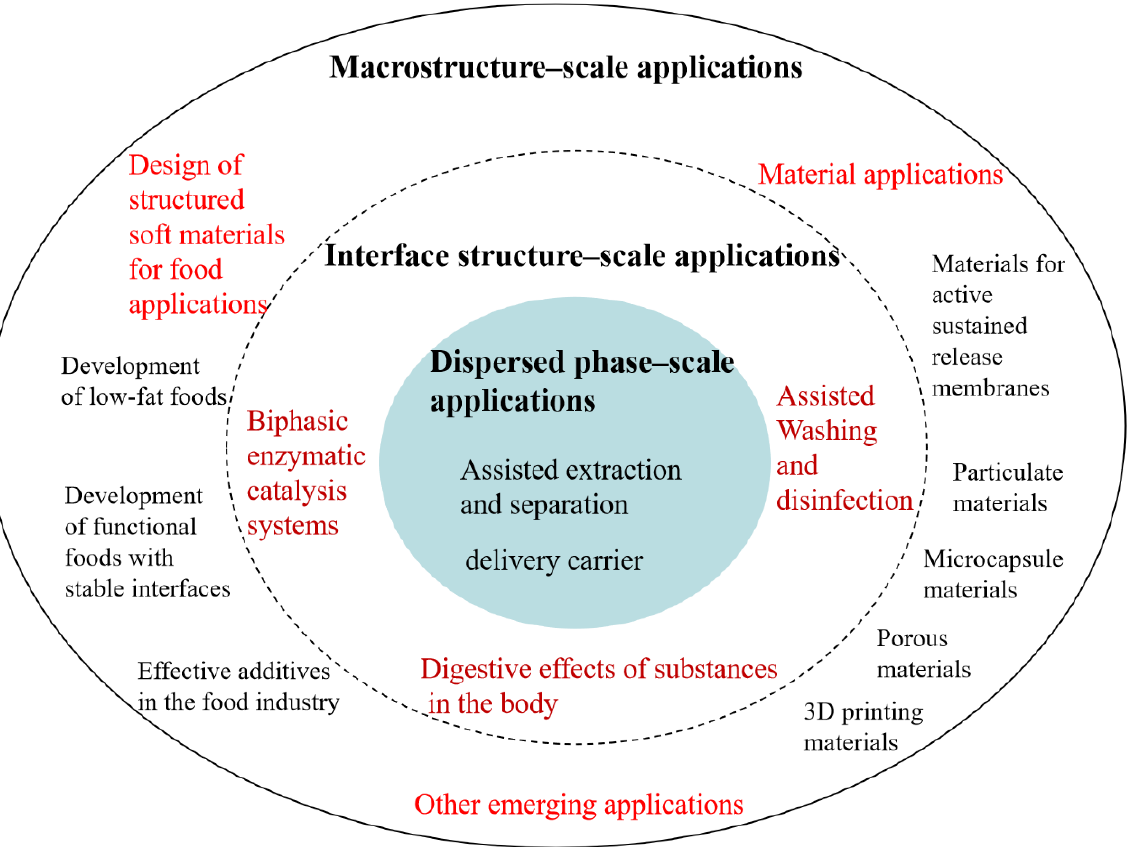
Figure 2. Applications of food-grade emulsions organized in terms of the dispersed phase, interface structure, and macrostructure scales.